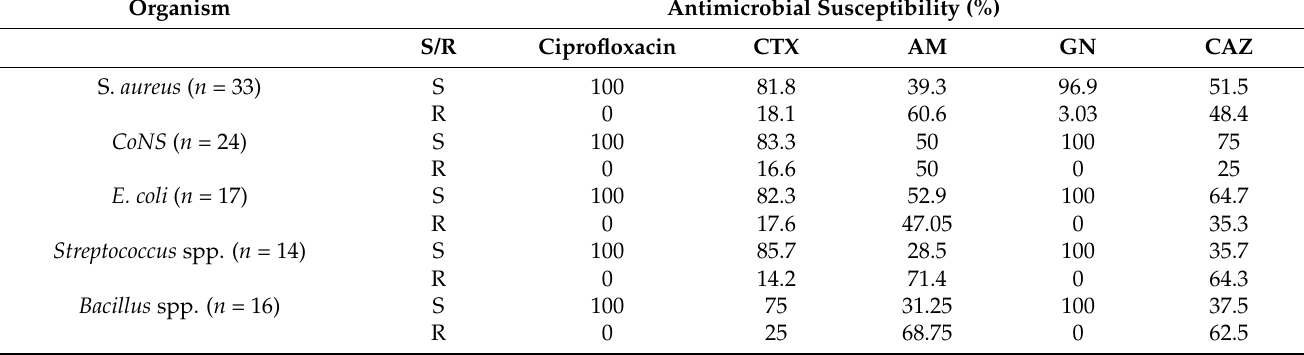
Table 2. Antimicrobial susceptibility profiles of bacterial isolates from mobile phones.